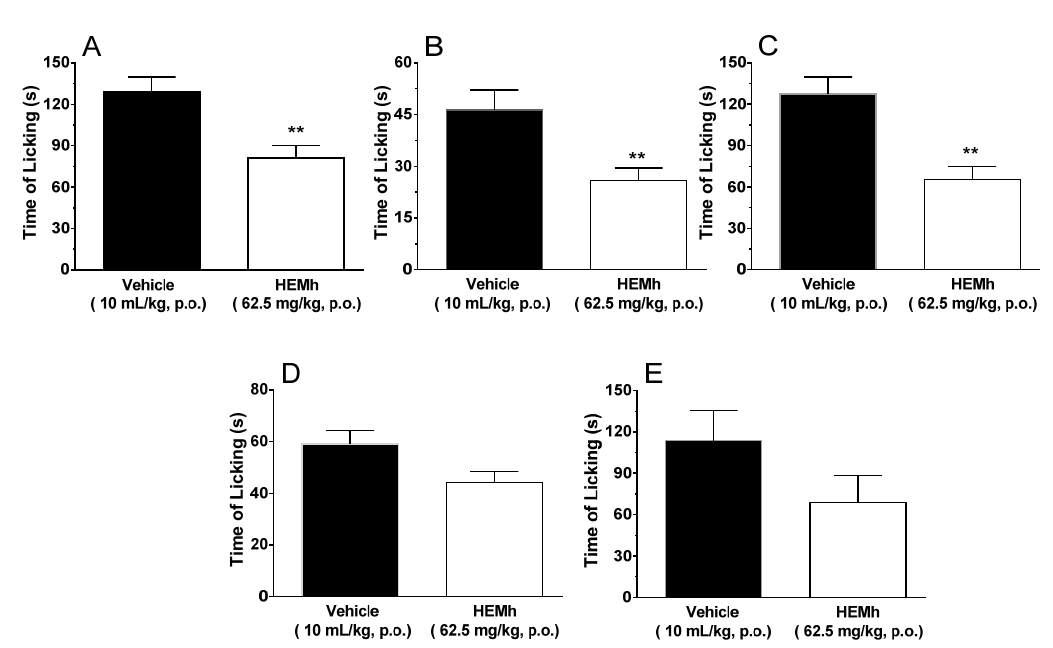
Figure 6 . Effects of the hydroalcoholic extract of the twigs of Machaerium hirtum (HEMh) on the nocifensive behavior of mice induced by an intraplantar injection of glutamate ( A ), cinnamaldehyde ( B ), acidified saline ( C ), capsaicin ( D ), and menthol ( E ). The column represents the mean of 6–10 animals and the vertical lines indicates the S.E.M. The asterisks denote the significance levels compared with the vehicle control group (** p < 0.01) using Student’s t -test.